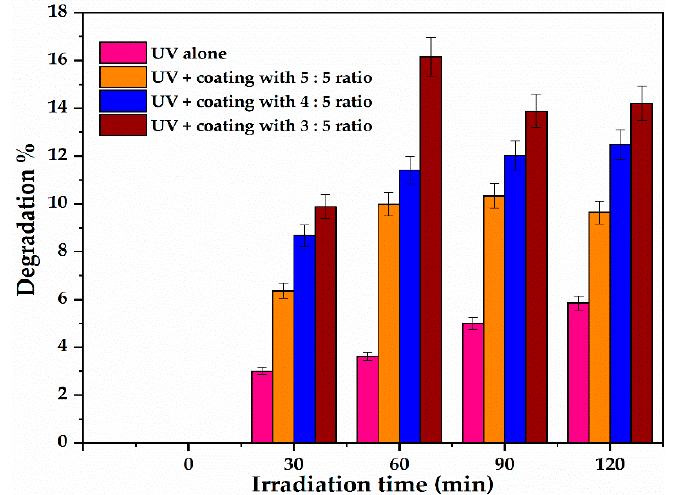
Figure 10. Photocatalytic activity of glass supported C-N-TiO 2 coatings formed at sol gel-solvent ratio from 3:5, 4:5, or 5:5 (Experimental conditions: O.II concentration 5 mg / L, volume 500 mL, pH 2.5, and irradiation time of 120 min. The experiment at each sol-gel to solvent ratio was duplicated ( n = 2).